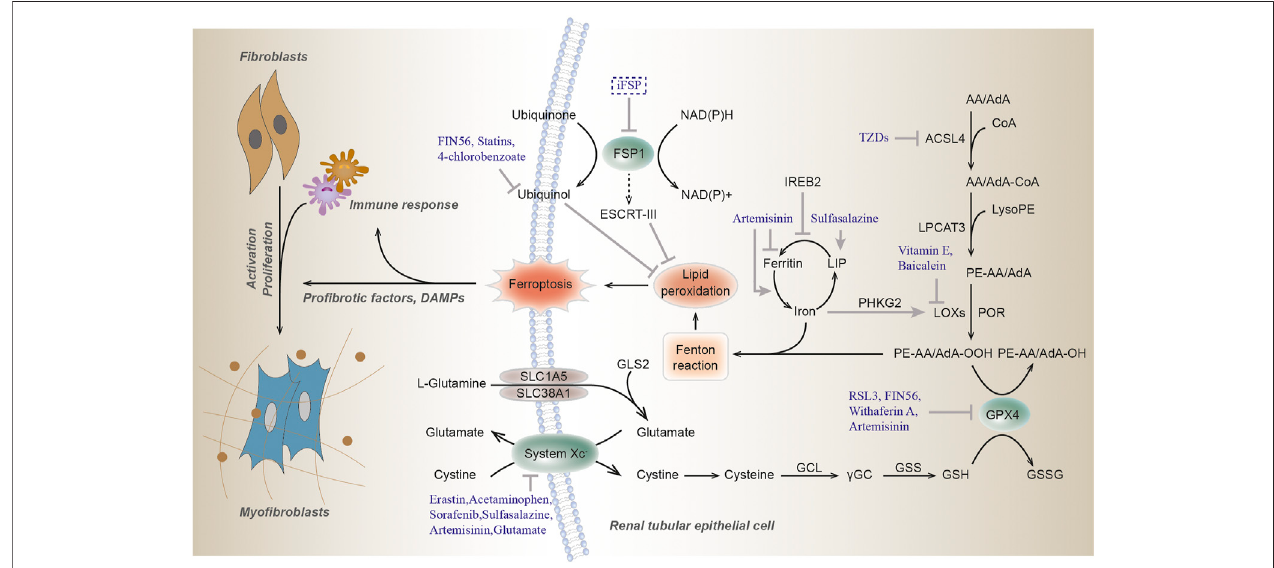
FIGURE 1 | Molecular mechanisms of ferroptosis. Ferroptosis is triggered by lethal lipid peroxidation caused by accumulation of intracellular free iron and/or dysfunction of antioxidant system. The commonly used ferroptosis regulators are shown here. Arrows indicate activation, while blunt lines indicate inhibition. GSH, glutathione; GPX4, glutathione peroxidase 4; GSSG, glutathione disul fi de; GCL, glutamate-cysteine ligase; γ GC, γ -glutamyl cysteine; GSS, glutathione synthetase; AA, arachidonic acid; AdA, adrenic acid; ACSL4, acyl-CoA synthetase 4; TZDs, thiazolidinediones; LPCAT3, lysophosphatidylcholine acyltransferase 3; LOXs, lipoxygenase; POR, cytochrome P450 oxidoreductase; FSP1, Ferroptosis suppressor protein 1; IREB2, iron responsive element binding protein 2; PHKG2, phosphorylase kinase G2; LIP,labile iron pool; GLS2, glutaminase2;SLC1A5,solute carrier family 1 member 5; SLC38A1, solute carrier family 38memberA;NAD(P)H, nicotinamide adenine dinucleotide phosphate; ESCRT-III, endosomal sorting complex required for transport-III; RSL3, (1S,3R)-RSL3.